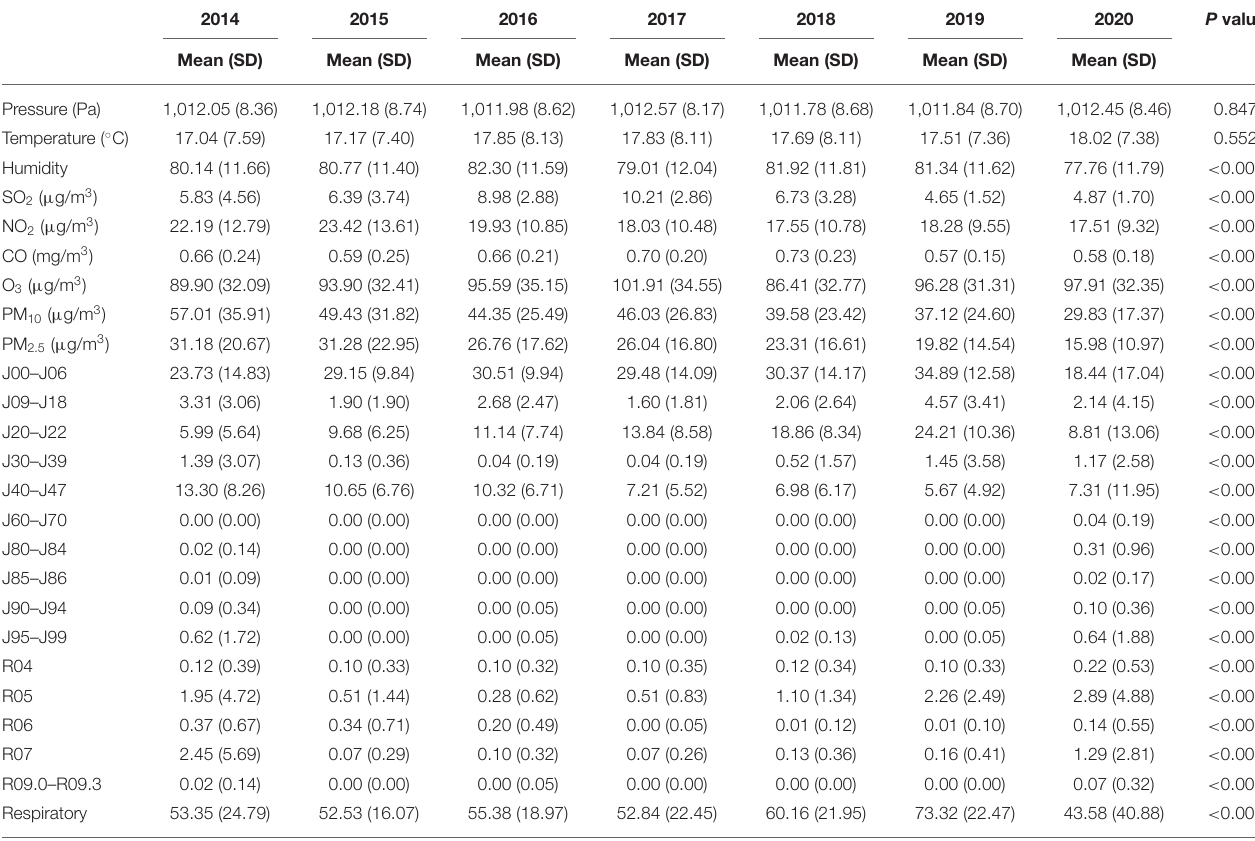
TABLE 1 | Descriptive statistics for daily outpatient visits, concentrations of air pollutants, and weather